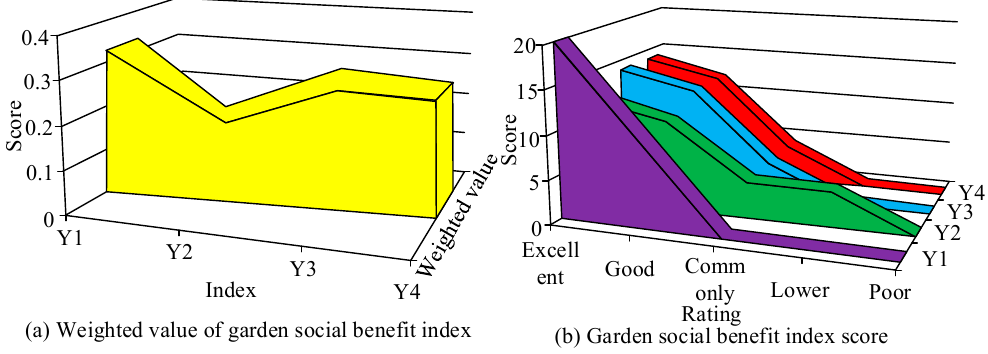
Figure 9. Evaluation results of the social benefits of Lanshan Mountain landscape architecture.